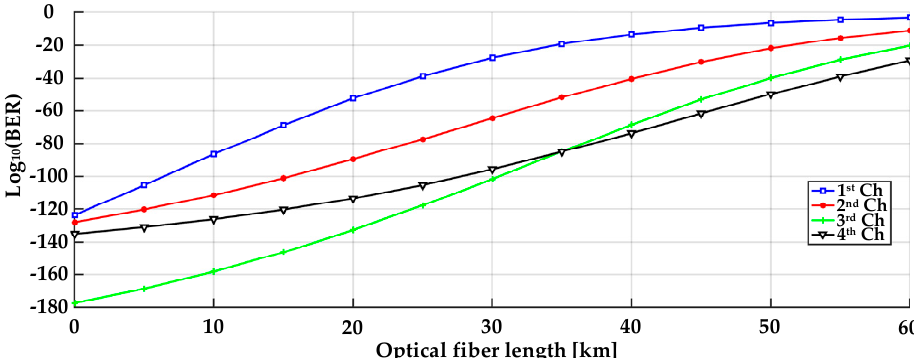
Figure 11. Quality of transmission (QoT) characteristics for the 10 Gbit / s NRZ-OOK signals in the 4-channel 200 GHz spaced IM / DD WDM-PON system: the fair comparison of BER vs. Optical fiber length for implemented microsphere-based OFC comb carriers’ performance.